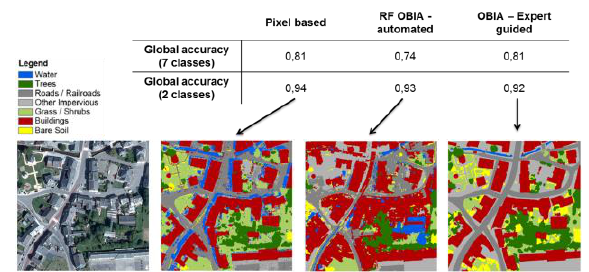
Figure 3. First prototype of dasymetric population map for 2014 at 1 ha of Wallonia (Hallot et al.,